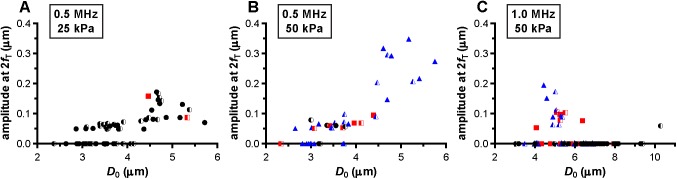
Amplitude at the second harmonic frequency, 2fT.For microbubbles insonified at a frequency of 0.5 MHz and P_ of 25 kPa (A), frequency of 0.5 MHz and P_ of 50 kPa (B), and frequency of 1 MHz and P_ of 50 kPa (C). For figure legend, see the rightmost column of Fig 2 and Fig 3. A value of 0 indicates no second harmonic was present.